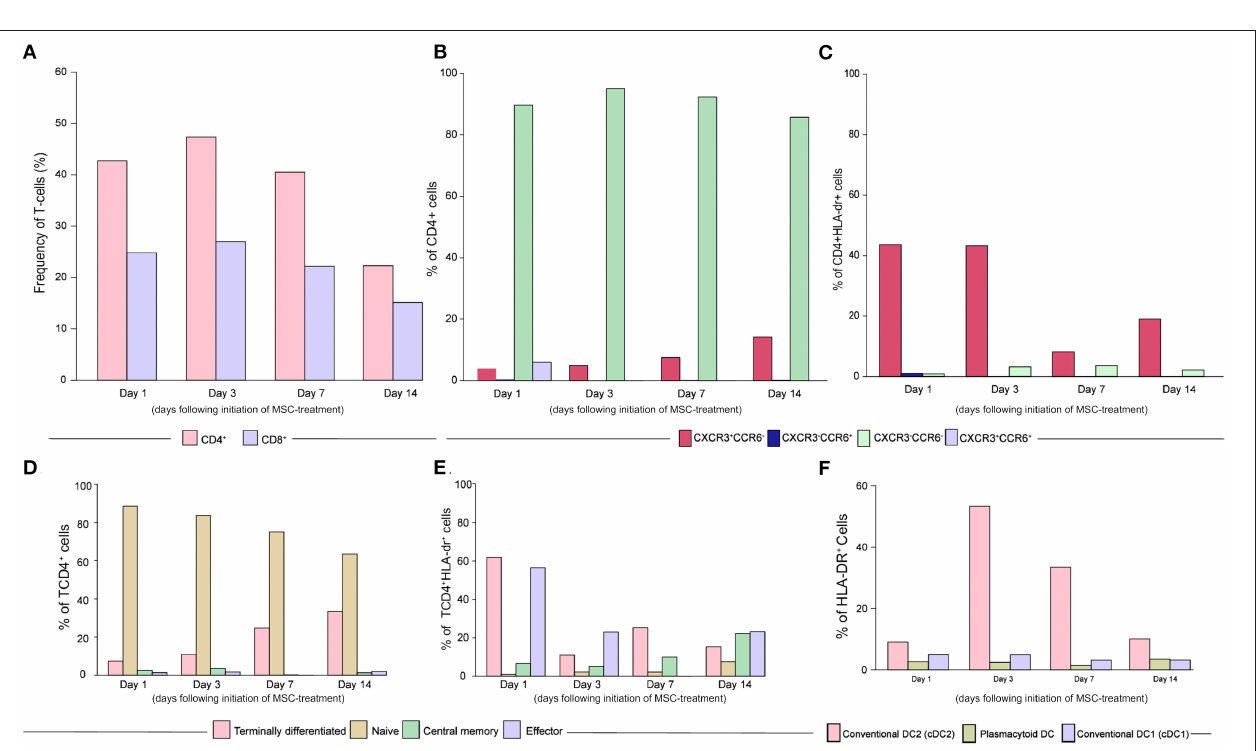
FIGURE 4 | Dynamics of CD4 + T helper subsets and dendritic cells turnover following treatment initiation. (A) Frequencies of CD4 + and CD8 + T Lymphocytes over time. (B) The differential expression of chemokine receptors CCR6 and CXCR3 in CD4 T cells are shown, further indicating the frequencies of Th1 (CXCR3 + CCR6 − ), Th1 Star (CXCR3 + CCR6 + ), Th2 (CXCR3 − CCR6 − ), and Th17 (CXCR3 − CCR6 + ) subpopulations. (C) The differential expression of chemokine receptors CCR6 and CXCR3 in activated CD4 T cells are shown, further indicating the frequencies of Th1 (CXCR3 + CCR6 − ), Th1 Star (CXCR3 + CCR6 + ), Th2 (CXCR3 − CCR6 − ), and Th17 (CXCR3 − CCR6 + ) subpopulations. (D) The frequencies of naïve (CD45 + CD27 + ), central memory (CD45 − CD27 + ), effector (CD45 − CD27 − ) and terminally differentiated cells (CD45 + CD27 − ) are shown, without activation. (E) The frequencies of naïve (CD45 + CD27 + ), central memory (CD45 − CD27 + ), effector (CD45 − CD27 − ), and terminally differentiated cells (CD45 − CD27 + ) are shown in activated (HLA − DR + ) cells. (F) Conventional dendritic cells subtype 2 (cDC2) frequencies increased on day 3. The frequency of conventional DC2 (HLA − dr + CD11c + CD141 − ), plasmacytoid DCs (HLA − dr + CD11c − CD123 + ), and conventional DC1 (HLA − dr + CD11c + CD141 +